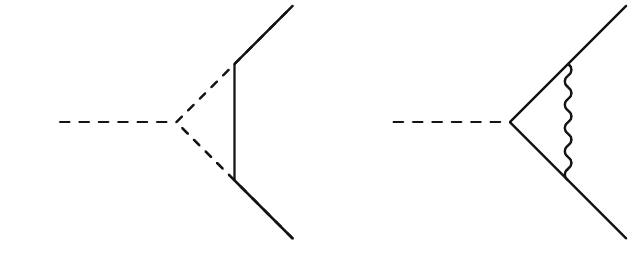
Fig. 3 Irreducible one-loop diagrams contributing to the threshold corrections to scalar-fermion couplings. The diagram on the right only shows up for MS–DR